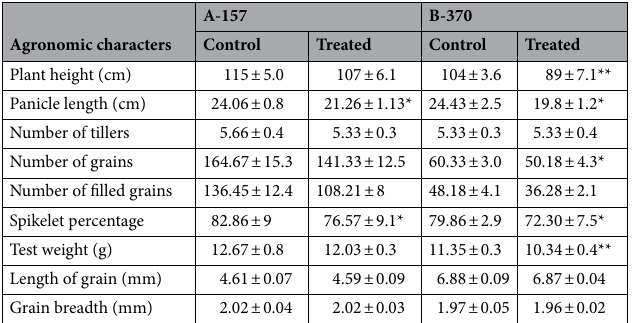
Table 1. Assessment of phenotypic traits in the cultivars under salt treatment. *Significant at p = 0.05 level. **Significant at p = 0.01.